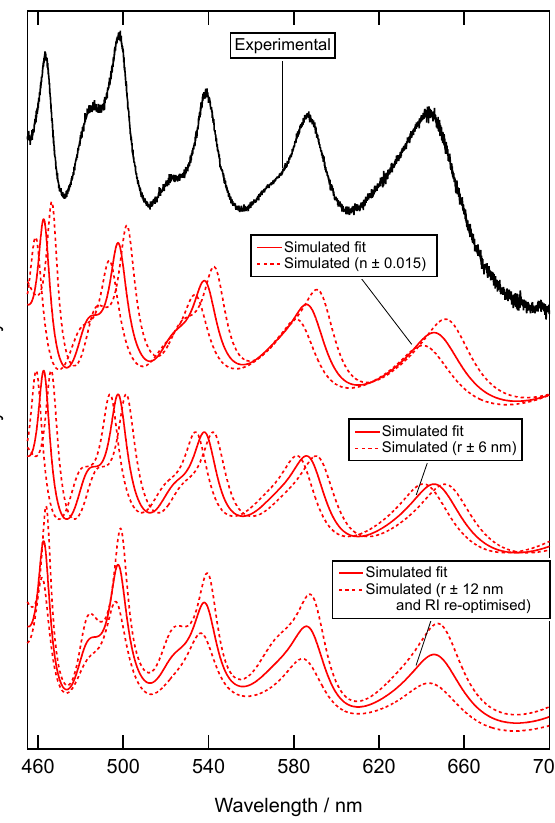
Figure 5. The experimental Mie spectra for the urban spring aerosol extract with the simulated best fit perturbed in three different sce- narios to demonstrate the sensitivity of fitting simulated Mie spec- tra to experimental Mie spectra. Initially the simulated fit (red solid line) is recalculated with a refractive index increased and de- creased by 0.015 ( n ± 0 . 015), followed by the simulated fit (red solid line) recalculated with a radius increased and decreased by 6nm ( n ± 6nm). The final set of simulated Mie spectra consider the simulated fit (red solid line) to be recalculated with a droplet radius increased and decreased by 12nm but the refractive index re- optimised to get the best fit to the experimental fit ( r ± 12nm and RI re-optimised): a clear demonstration that the quoted uncertainties in radius ( ± 6nm) and refractive index ( ± 0.015) are conservative and more than